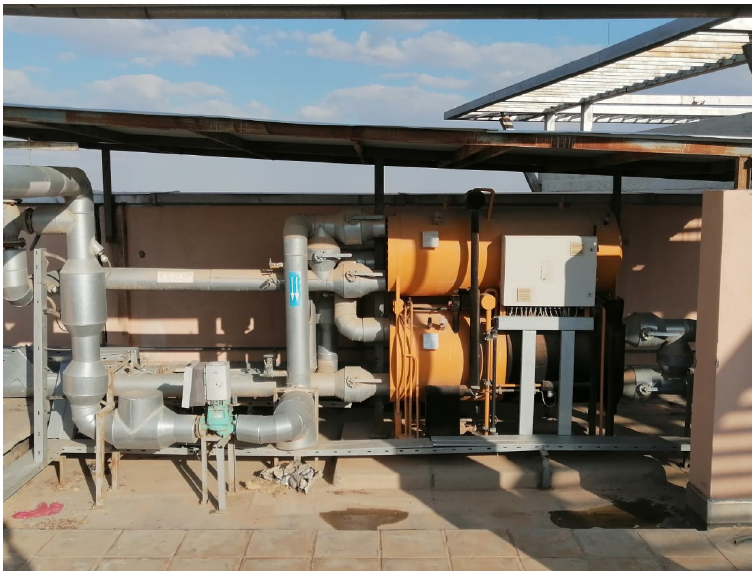
Figure 6. Water-lithium bromide ( H₂O-LiBr) 160 kW absorption chiller on GJU rooftop.